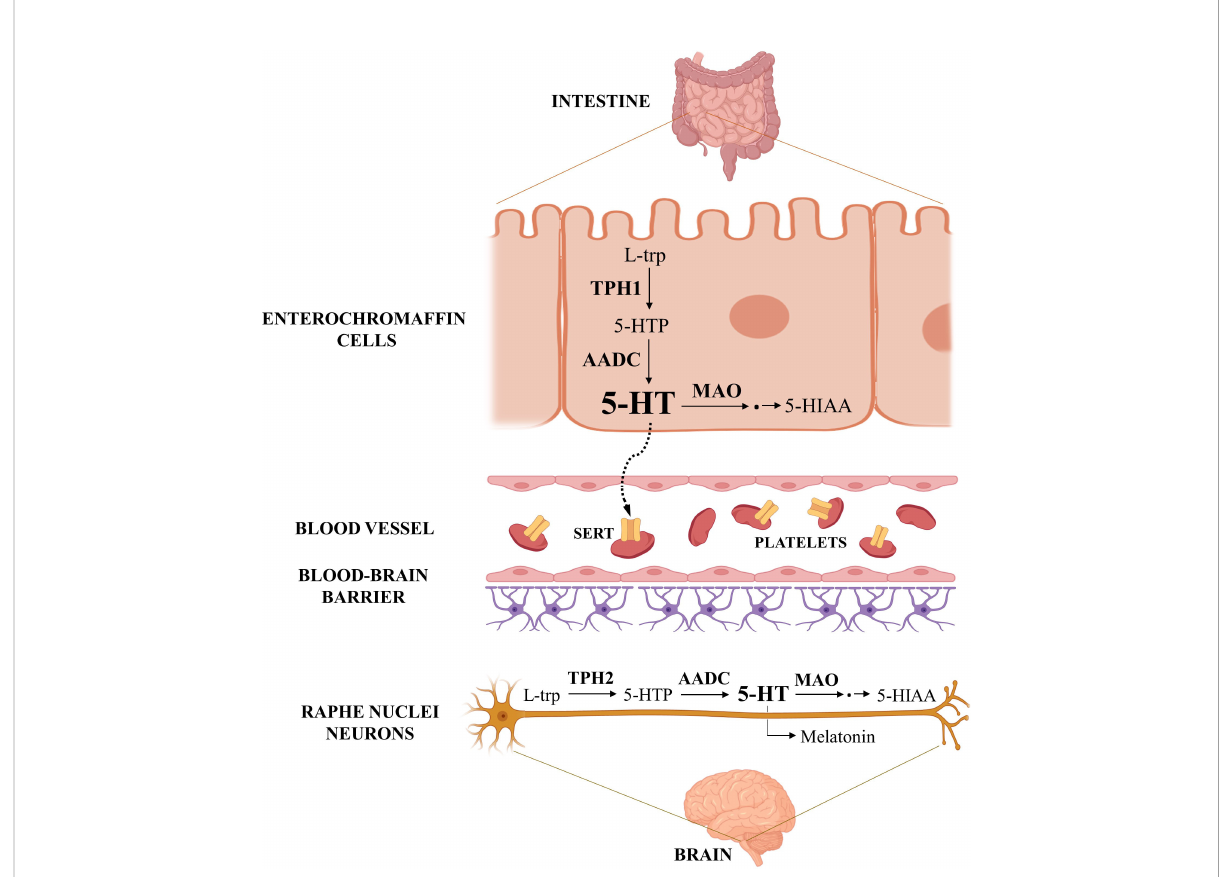
FIGURE 1 Serotonin metabolism. The fi gure shows the serotonin pathways in the gastrointestinal tract and in the central nervous system, the main sites of its synthesis in the human body. Serotonin synthesized in the enterochromaf fi n cells of the intestine is released into the portal circulation, taken up into platelets, and distributed to various other organs. Created with